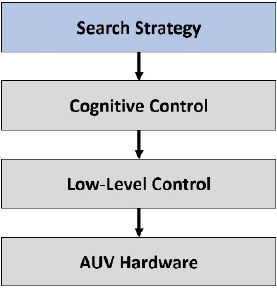
Figure 12. Overview of different layers involved for autonomous underwater vehicle (AUV) oper- ation for submarine groundwater discharge (SGD) search.